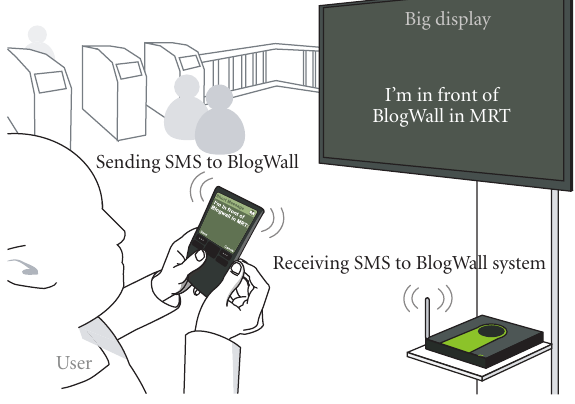
Figure 1: Concept design of